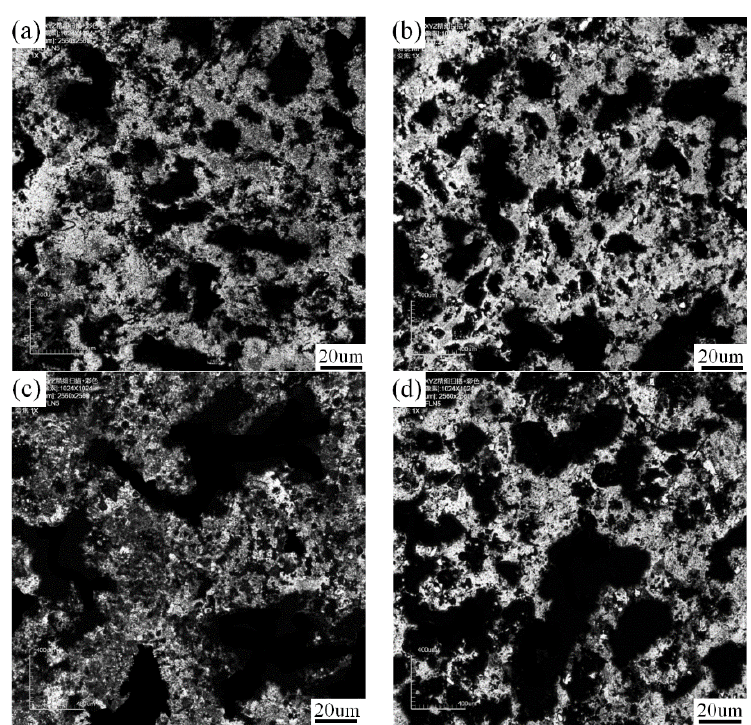
= 0.2; ( b ) x = 0.4; ( c ) x = 0.6; ( d ) x = x high-entropy alloy (( a ) x